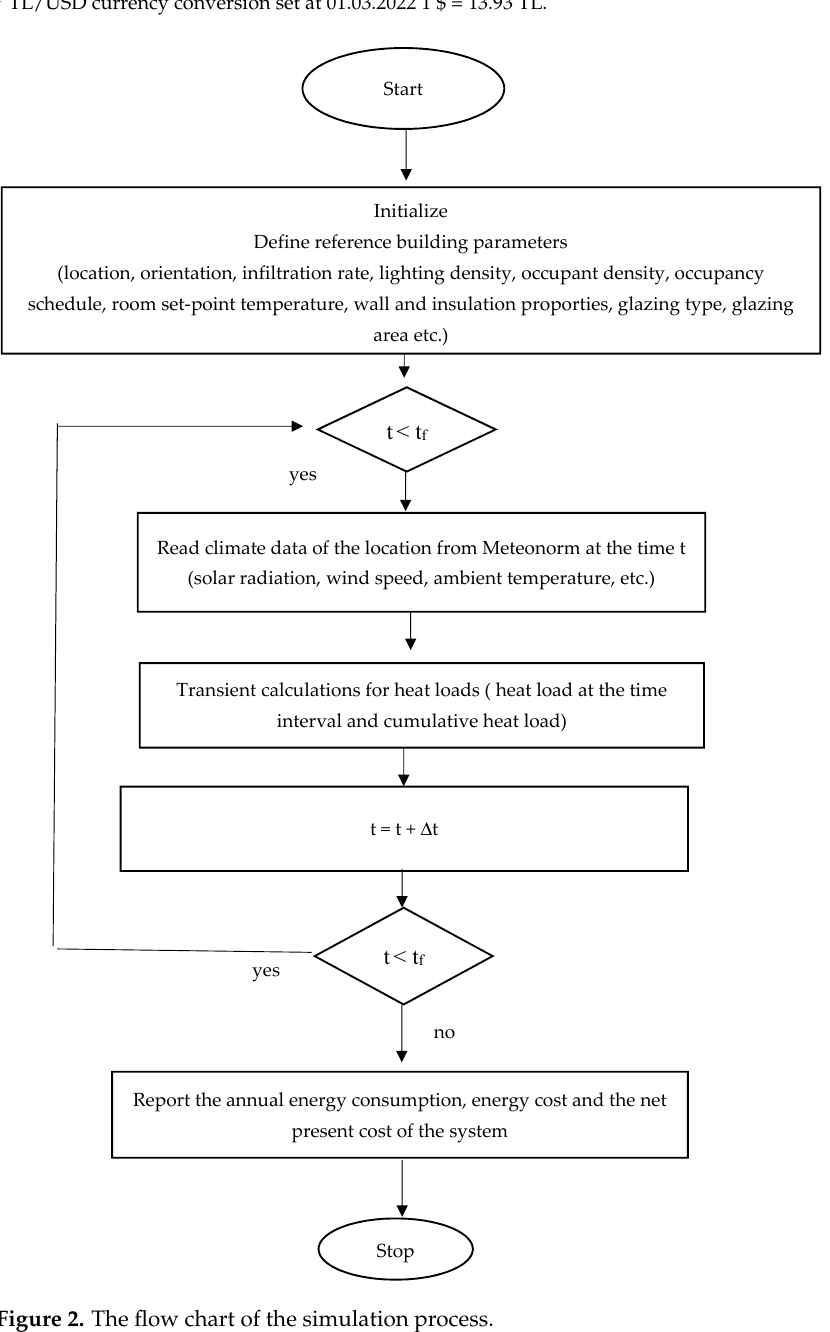
Figure 2 . The flow chart of the simulation process. Figure 2. The flow chart of the simulation